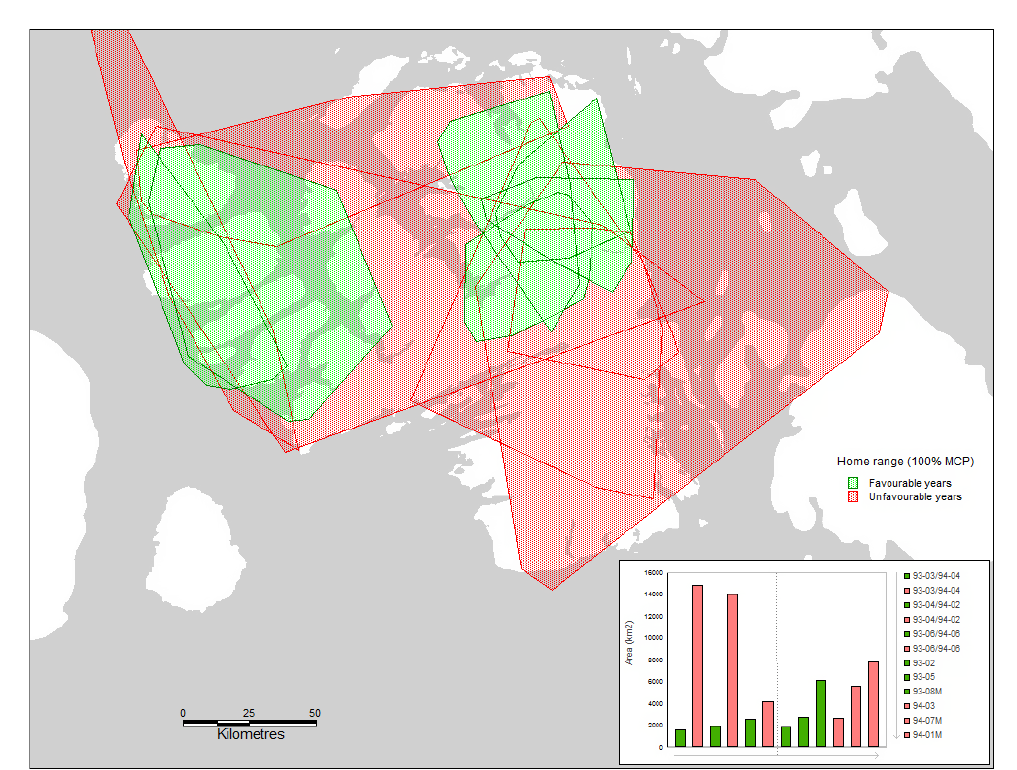
Figure 2. Minimum convex polygons (100%) for 1993–94 and 1994–97 satellite-collared caribou relative to favourable (green polygons) and unfavourable (red polygons) winters (see text); Bathurst Island Complex, NU (derived from F. L. Miller.